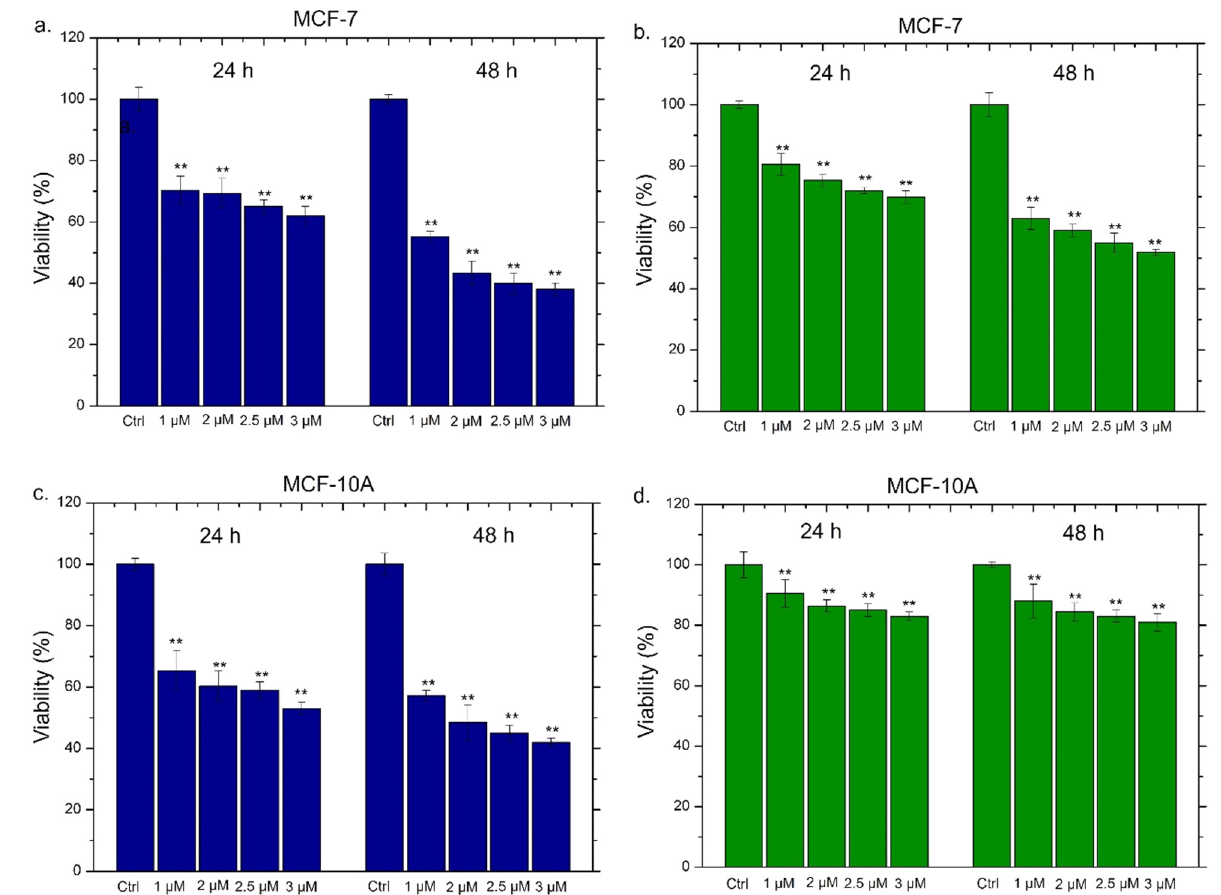
Figure 10. Viability assay performed on MCF-7 and MCF-10A cell lines exposed to 1 µM, 2 µM, 2.5 µM and 3 µM of conventional Ag NPs ( a , c ) and green Ag NPs ( b , d ) after 24 h and 48 h. The viability of cells exposed to NPs was normalized to untreated cells (control). The positive control was repre- sented by cells incubated with 5% DMSO (data not shown). Data reported were the mean ± SD from three independent experiments compared with the control ( n = 8) for p- value < 0.01 (<0.01 **). Table 2. IC50 values calculated on data measured by viability assays reported in Figure 10.